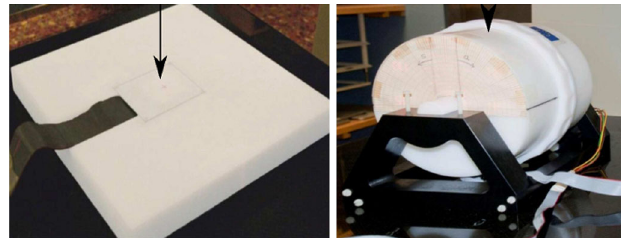
FIG. 2. The slab phantom (left side) and the cylindrical rotat- ing phantom (right side). The arrows show the direction of the beam.